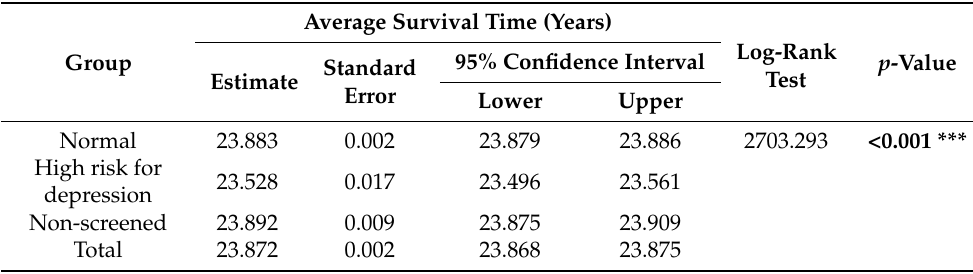
Table 6. Survival function of the normal, high-risk, and non-screened groups based on the log-rank test. Average Survival Time (Years) Log-Rank 95% Confidence Interval p -Value Group Standard Test Estimate Error Lower Upper Normal 23.883 0.002 23.879 23.886 2703.293 <0.001 *** High risk for 23.528 0.017 23.496 23.561 depression Non-screened 23.892 0.009 23.875 23.909